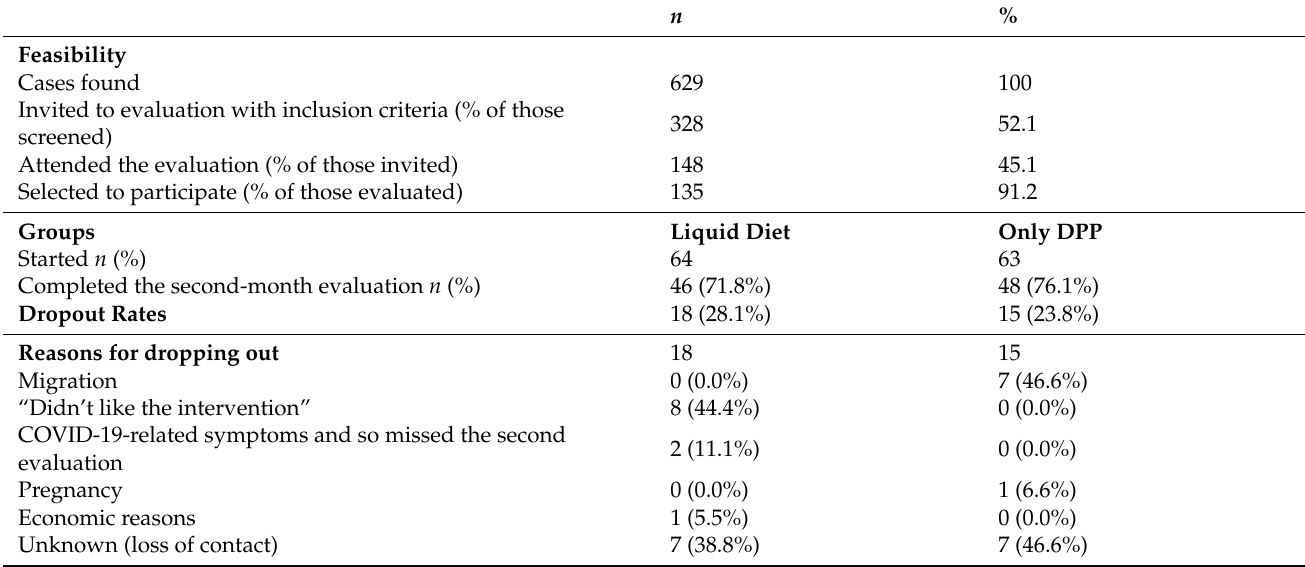
Table 1. Feasibility assessment in the first phase of the